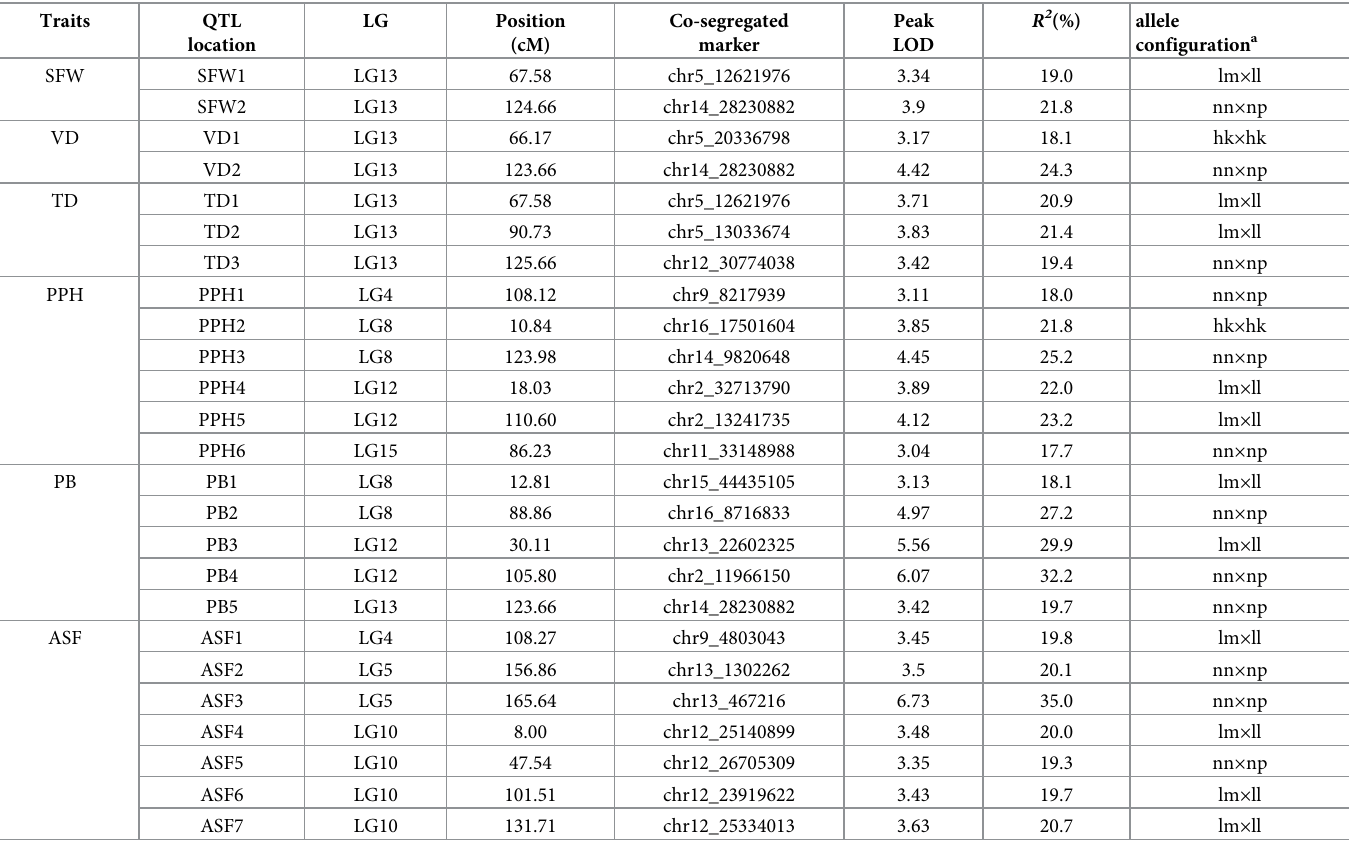
Table 4. QTL mapping results for hawthorn fruit trait of ’Shandongdamianqiu’ × ’Xinbinruanzi’. Traits QTL